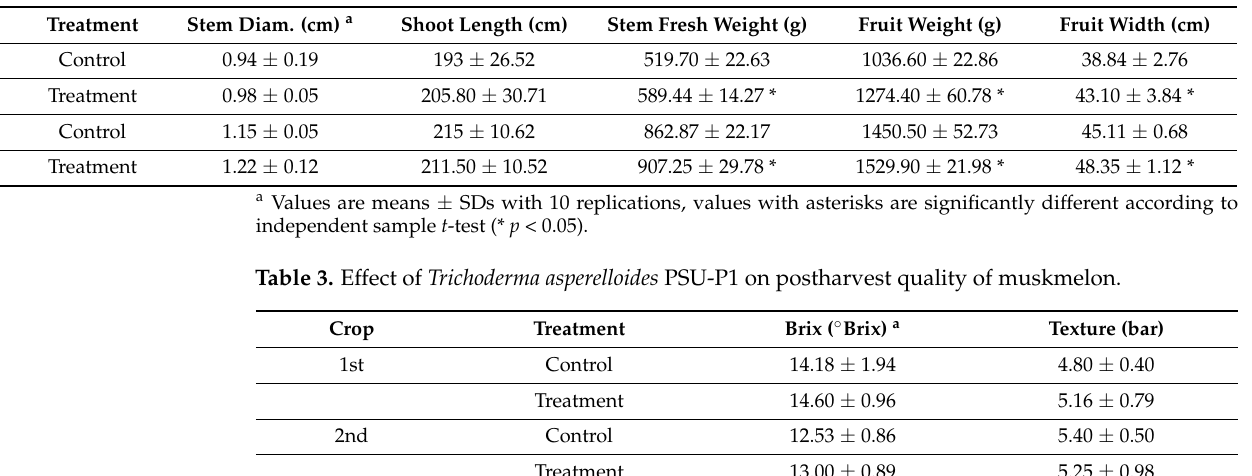
Table 2. Effect of Trichoderma asperelloides PSU-P1 on muskmelon growth.